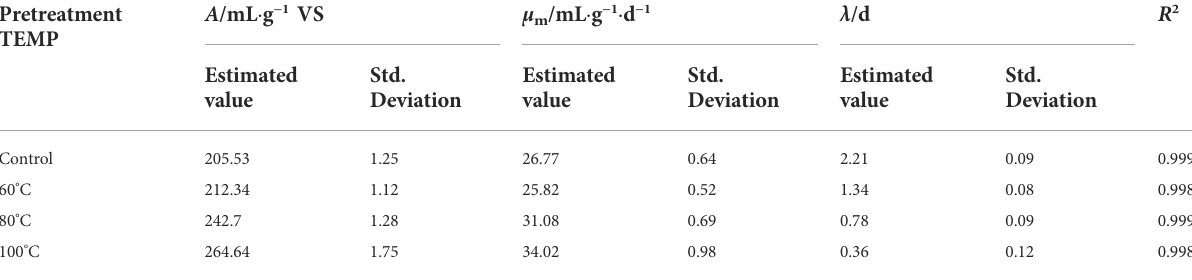
TABLE 2 Fitting results of methane production kinetics in BMP test. Pretreatment